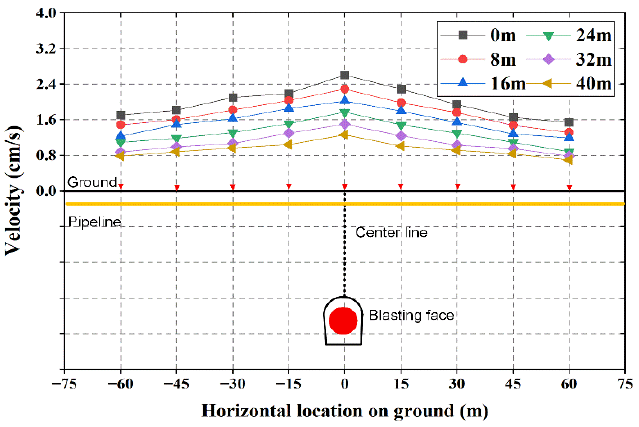
Figure 9. Distribution of the surface soil’s PPV.